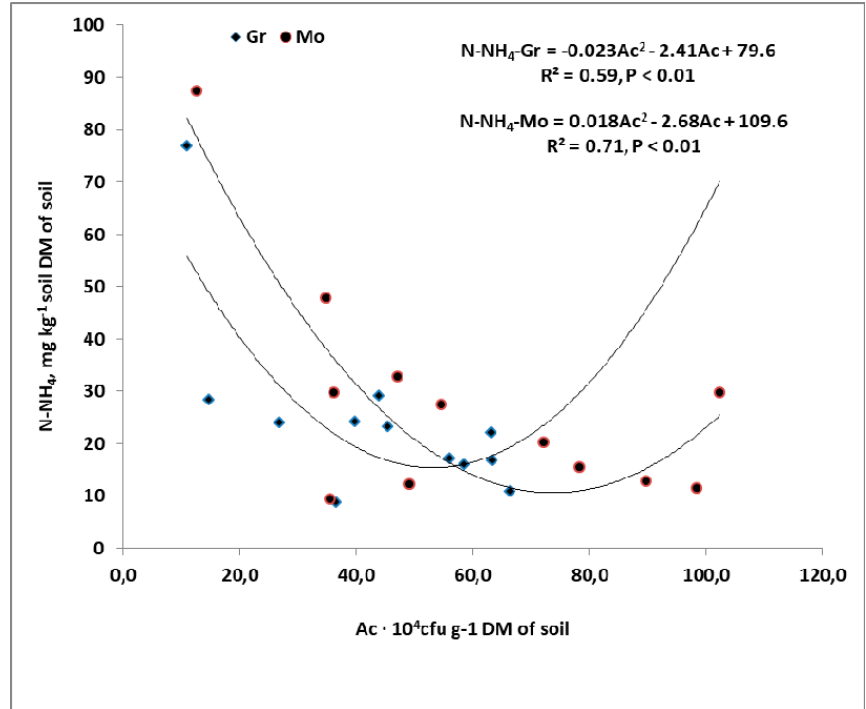
Magnesium, P-Phosphorus, K-Potassium, Na–Sodium.